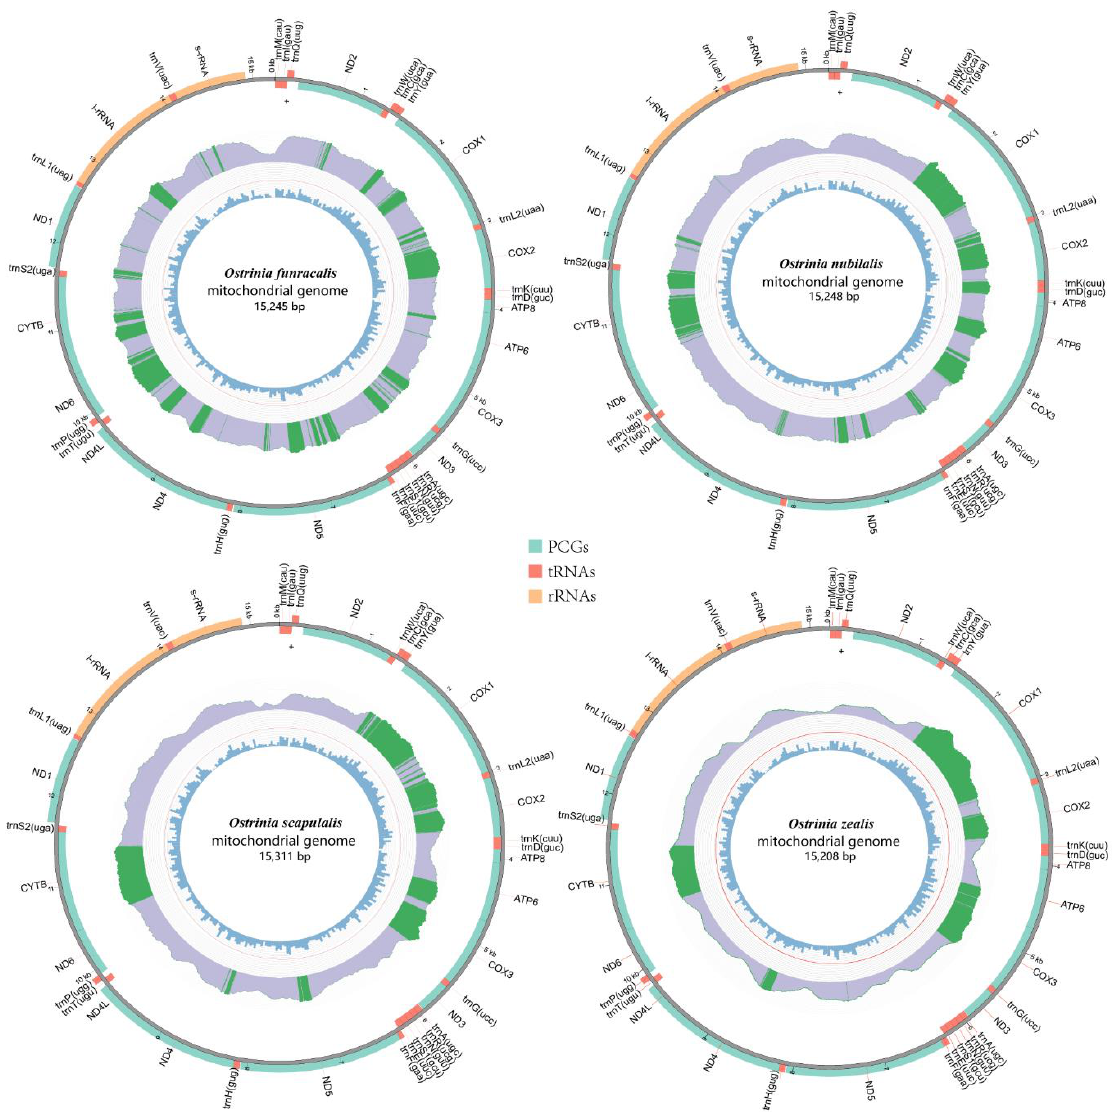
Figure 1. Complete mitochondrial genomes of four species. The innermost circle and middle circle indicate the GC content and read depth distribution, respectively. Light purple blocks show the depth upper than the minimum (default 20); the green blocks show the depth greater than the upper quartile and the green line indicates the outline. The outermost circle shows the arrangement of the genes: blue for the CDS, red for tRNAs, and orange for rRNAs. Table 2. Nucleotide composition and skewness of five Ostrinia spp. mitogenomes.